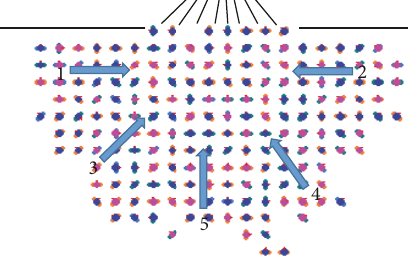
Figure 1: Evacuation without shunt wall.